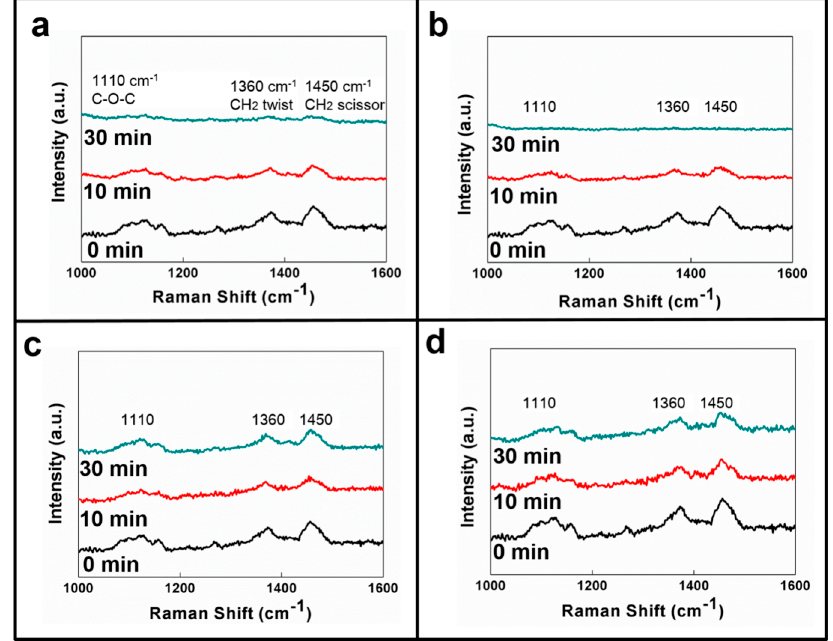
Figure 4. Raman spectra for HPMC films soaked in ( a ) water; ( b ) methanol; ( c ) ethanol; and ( d ) acetone for 0, 10 and 30 min.